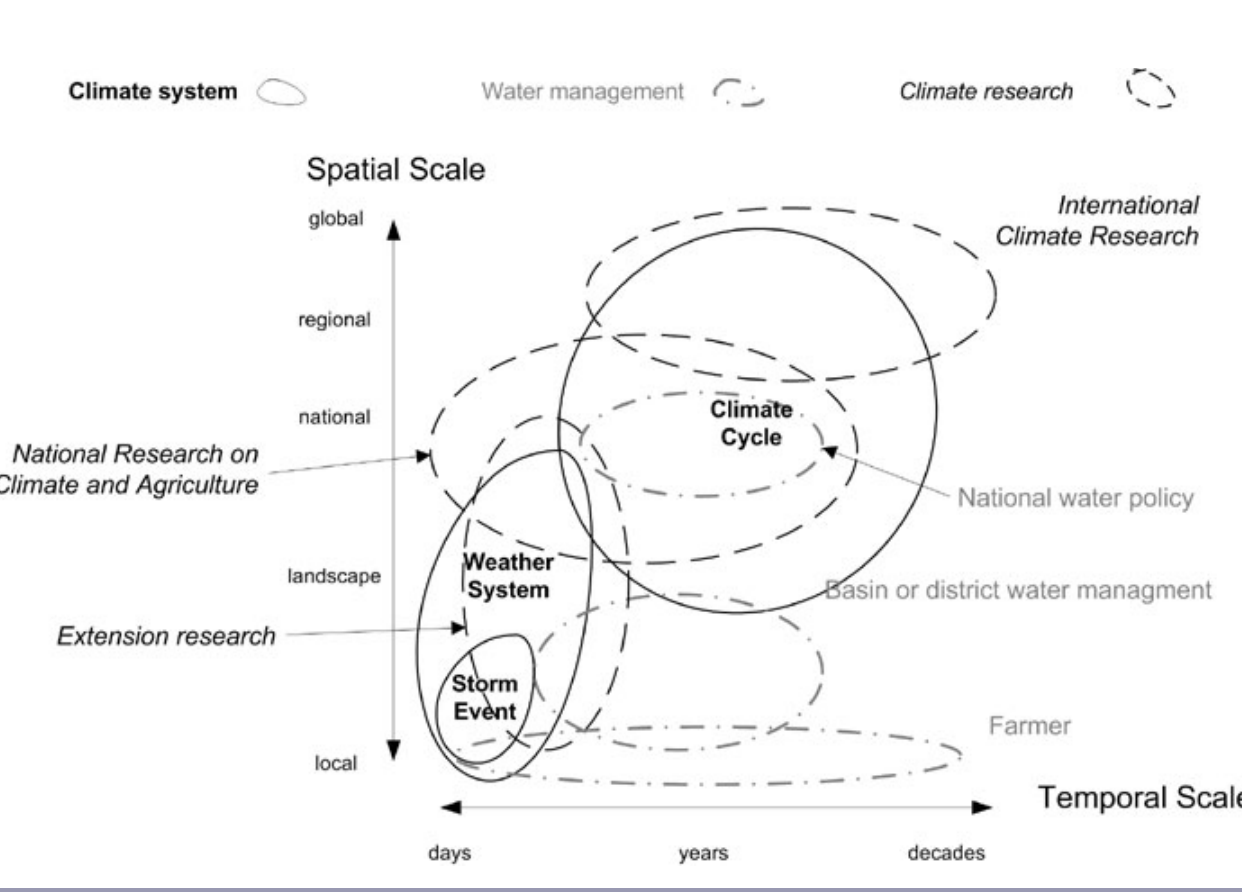
Fig. 3 . Schematic example of interaction across spatial, organizational, and temporal scales and levels. This schematic diagram can be used to illustrate the spatial and temporal dimensions of biogeophysical phenomena (the climate-related system represented as a solid line) and the interaction of two human domains: climate research (the long hashed line) and water management (hash-dotted lines). In this case, gaps exist in the human systems across levels within domains, e.g., international climate research does not link with national or subnational research or forecasting, and national water policy does not link with local water management) and across scales. This diagram is based on an original figure by Clark (1987) with recent additions by